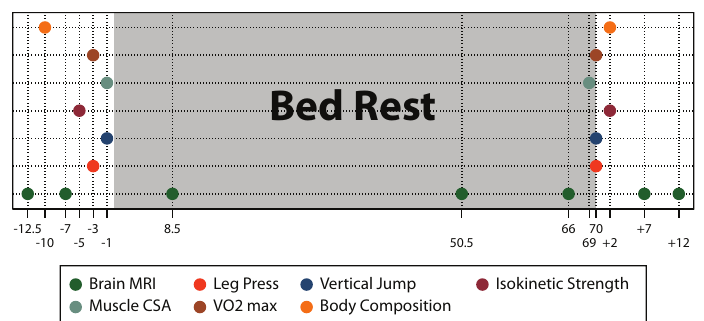
Fig 2. Time line of data collection of brain MRI and physical fitness measures. The x-axis indicates the number of days relative to the HDBR intervention (e.g., -12.5 = 12.5 days pre-HDBR; 8.5 = days in HDBR; and +2 = 2 days post- HDBR). Brain MRI = structural T1-weighted MRI, diffusion weighted imaging, and resting state functional connectivity MRI; Leg Press = lower body strength (isometric, isokinetic, total work); Vertical Jump = vertical jump (height and Watt) Isokinetic Strength = isokinetic knee and ankle extension and flexion strength; Muscle CSA = muscle cross-sectional area (soleus, quadriceps, hamstrings); VO2 max = rate of oxygen consumption during peak performance; Body Composition = fat mass and fat free